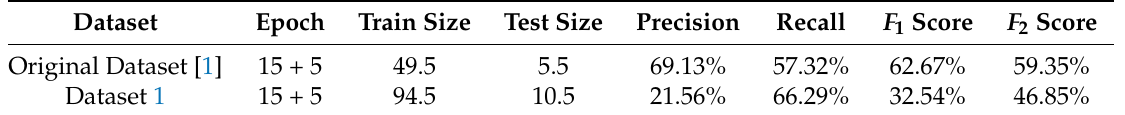
Table 3. The results of the effect of Dataset